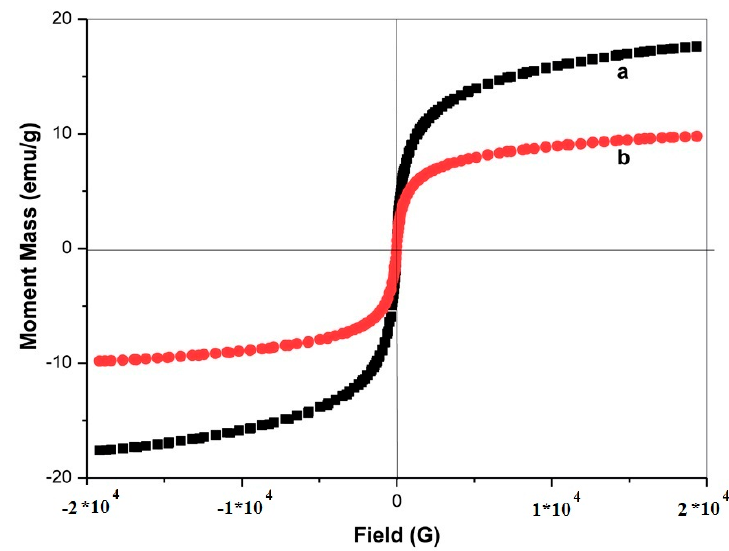
Figure 11. The magnetization curve of fresh GO/Fe 3 O 4 / L -pro ( a ) and reused GO/Fe 3 O 4 / L -pro after eight recycling ( b ).